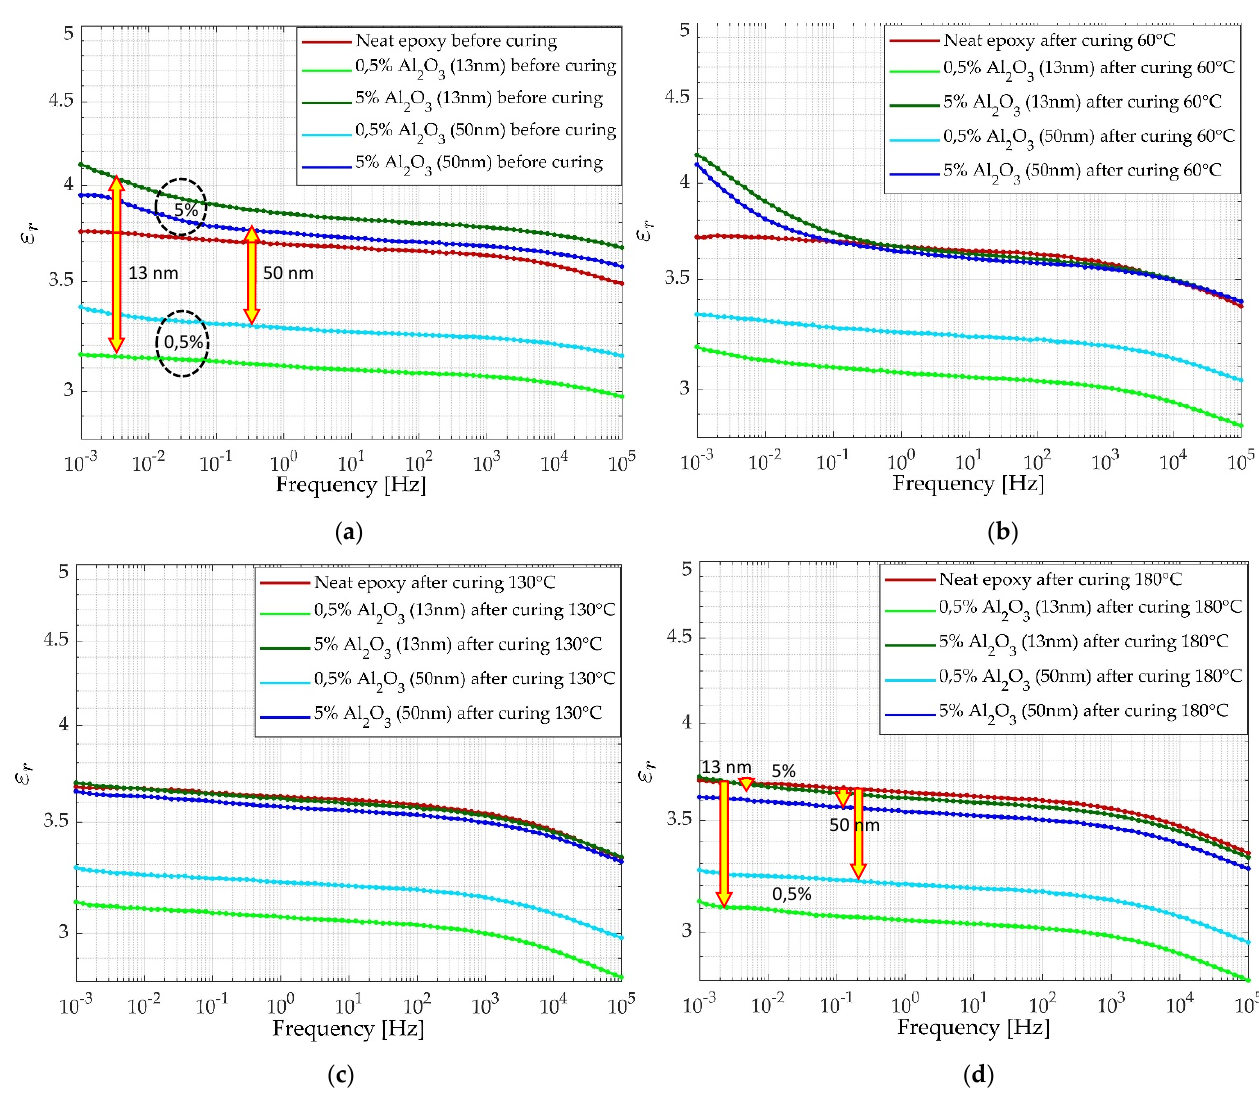
Figure 11. Selected curing temperature-dependent broadband characteristics of the dielectric constant for Al 2 O 3 nanoparticles with an average size of 13 nm and <50 nm, for two limit values of wt% used during the tests, 0.5% and 5.0%: ( a ) new, before curing, ( b ) after thermal curing at 60 °C, ( c ) after thermal curing at 130 °C, ( d ) after thermal curing at 180 °C.